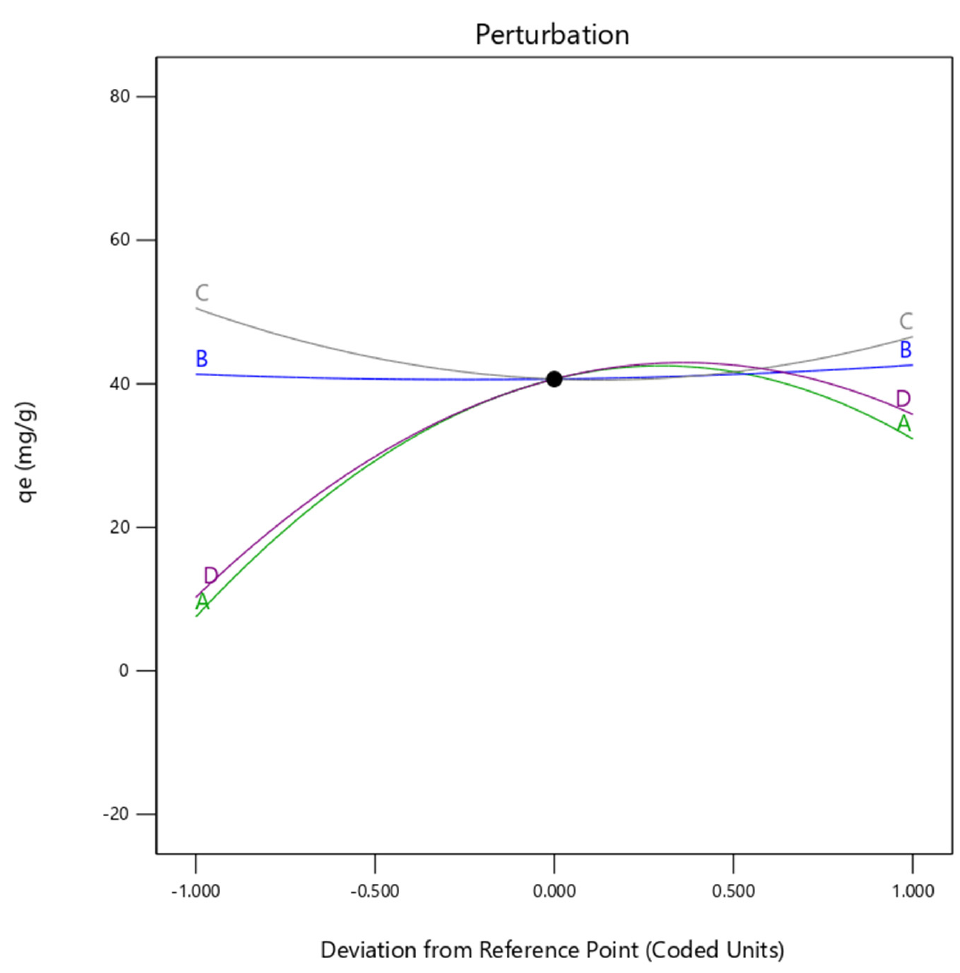
Figure 14. Perturbation plot of Cu(II) removal efficiency onto H + Dowex-M4195 chelating resin from the selected quadratic model related to the pH, Time, Dose, Conc. and q e.